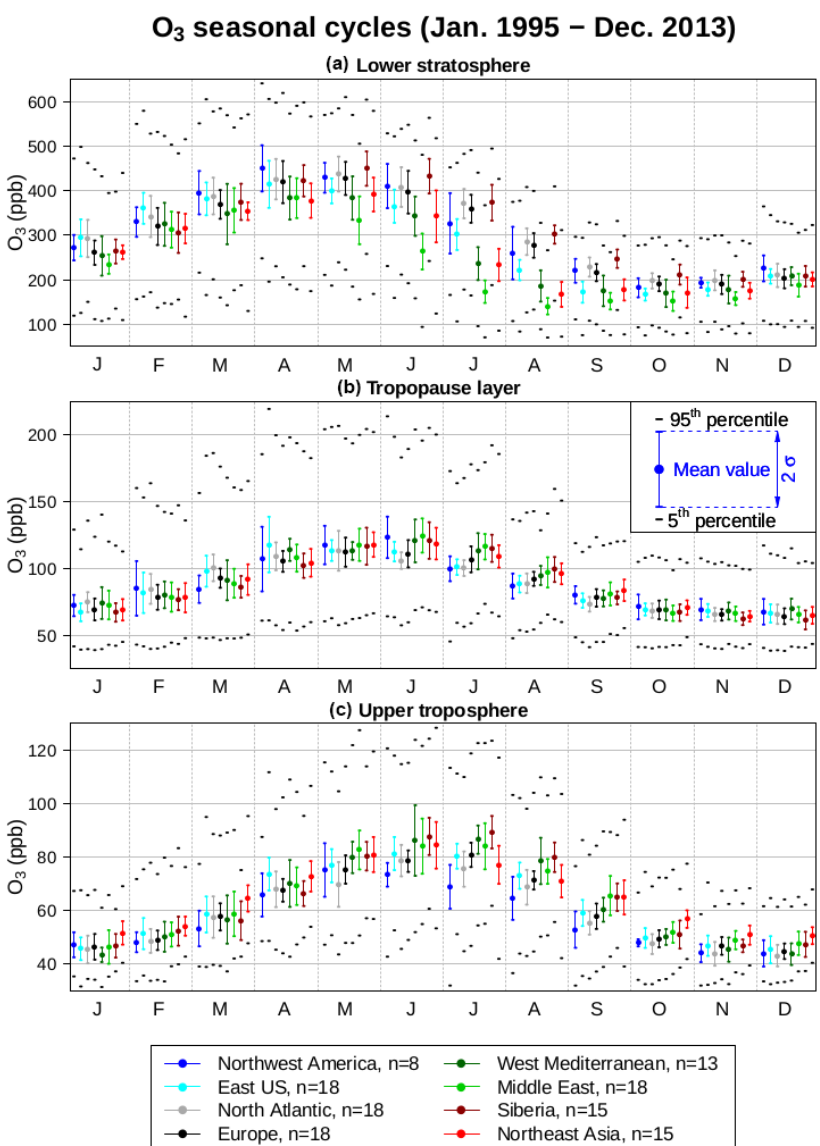
Figure 7. Seasonal cycles of O 3 for the monthly mean value (coloured points) and the 5th and 95th percentiles (lower and upper black ticks respectively). The interannual variability (coloured error bars) corresponds to the interannual standard deviation of the monthly mean value σ . From bottom to top, the graphs represent the cycles in the upper troposphere, tropopause layer, and lower stratosphere. The amount of years taken into account in the calculation of the upper-tropospheric O 3 cycles is indicated in the bottom legend as the number n